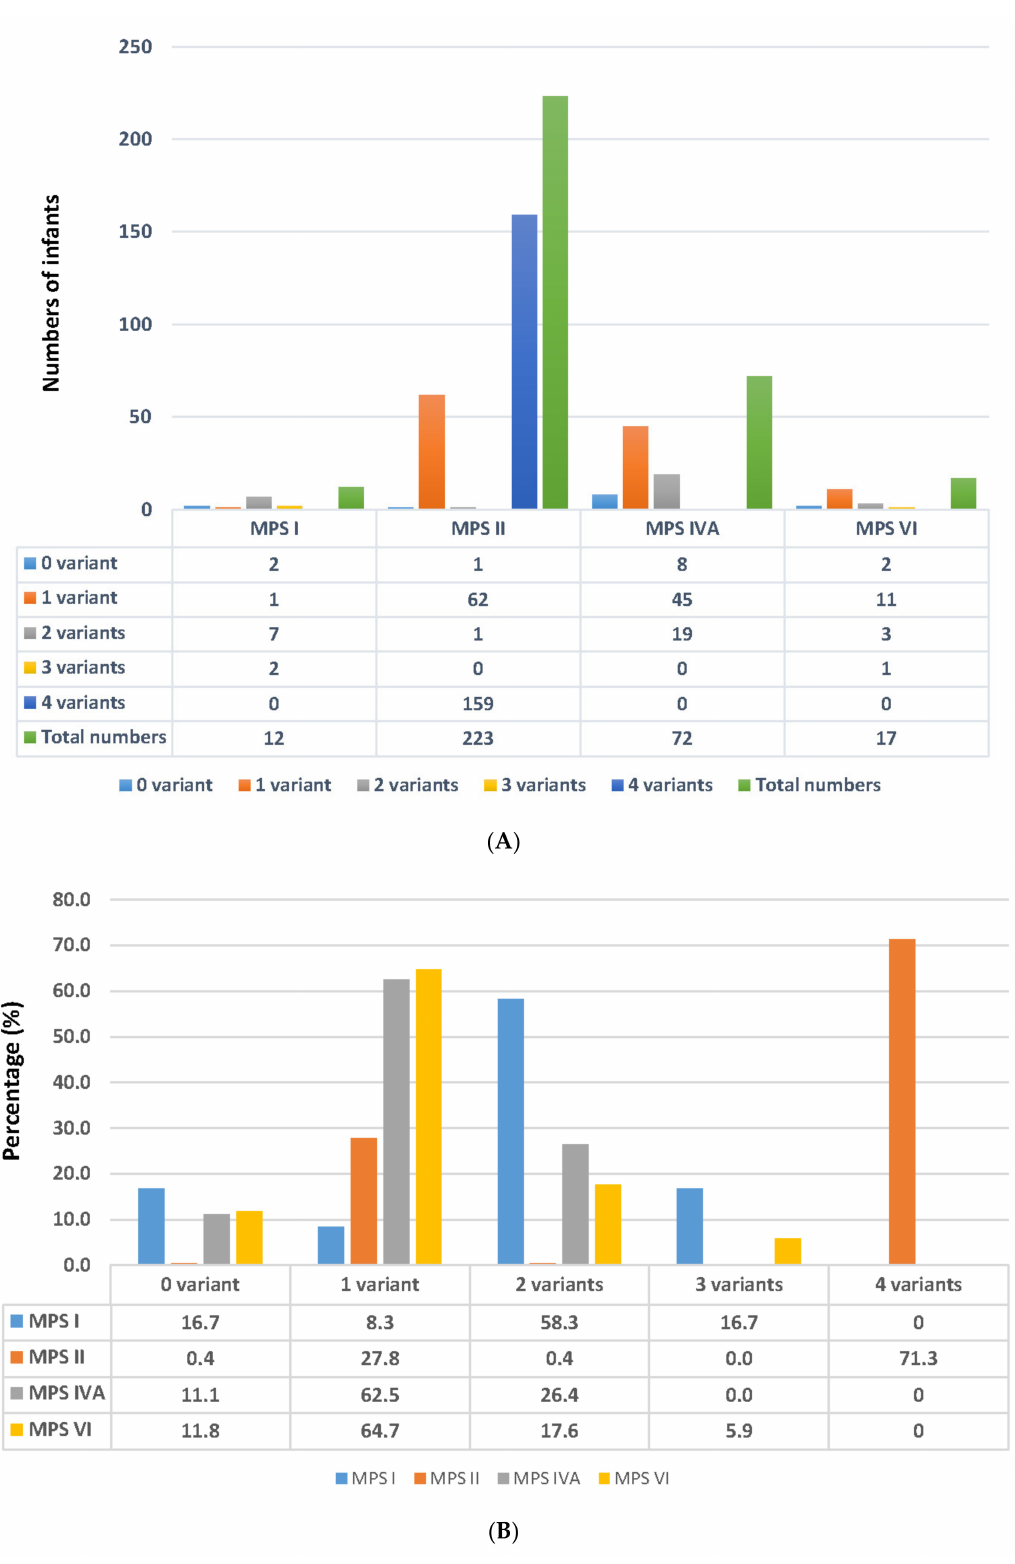
Figure 2. The number of variants detected in the suspected referred infants.The number of variants in the suspected cases by type of MPS ( A ); the incidence ratesof MPS according to the number of variants ( B ). The number of cases with zerovariants indicates the false-positive rate (%) of referred cases from newborn screening